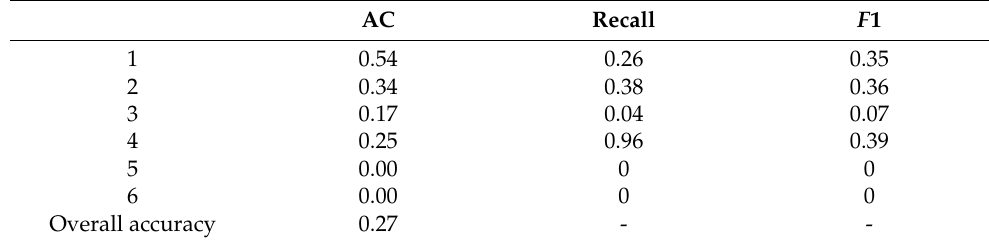
Table 7. Statistical results for the SVM